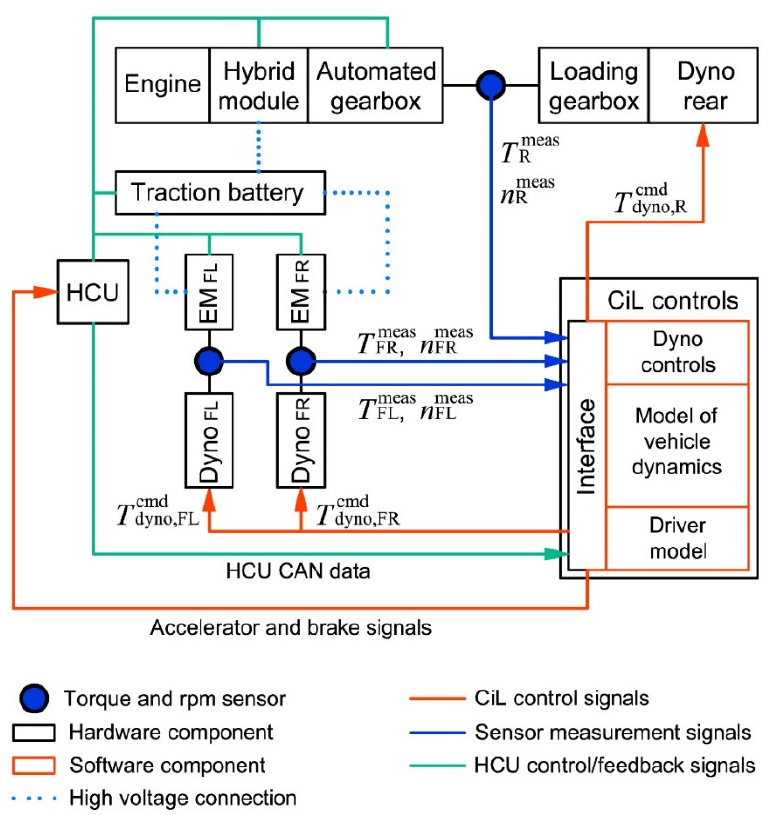
Figure 4. CiL system hardware arrangement, control loops, and data flows.